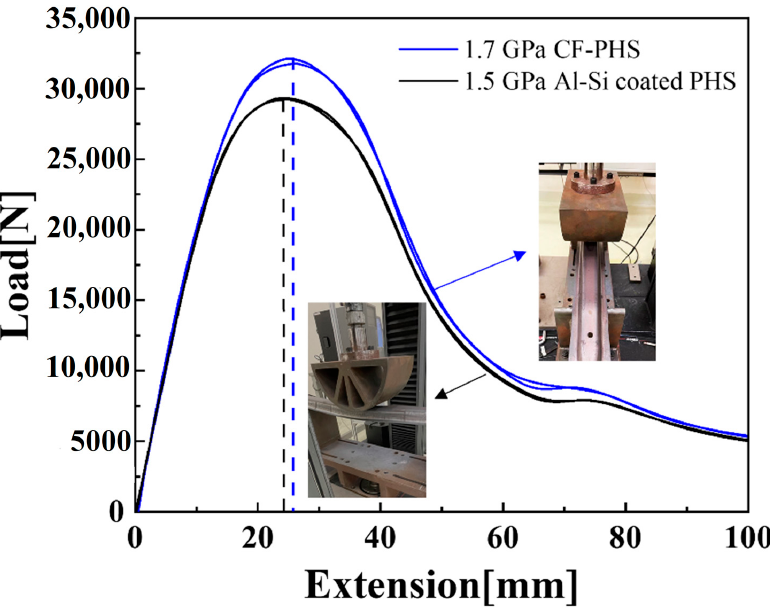
Figure 11. Component level three-point bending curves of prototype door impact beams for 1.7 GPa CF-PHS and 1.5 GPa Al-Si-coated PHS.